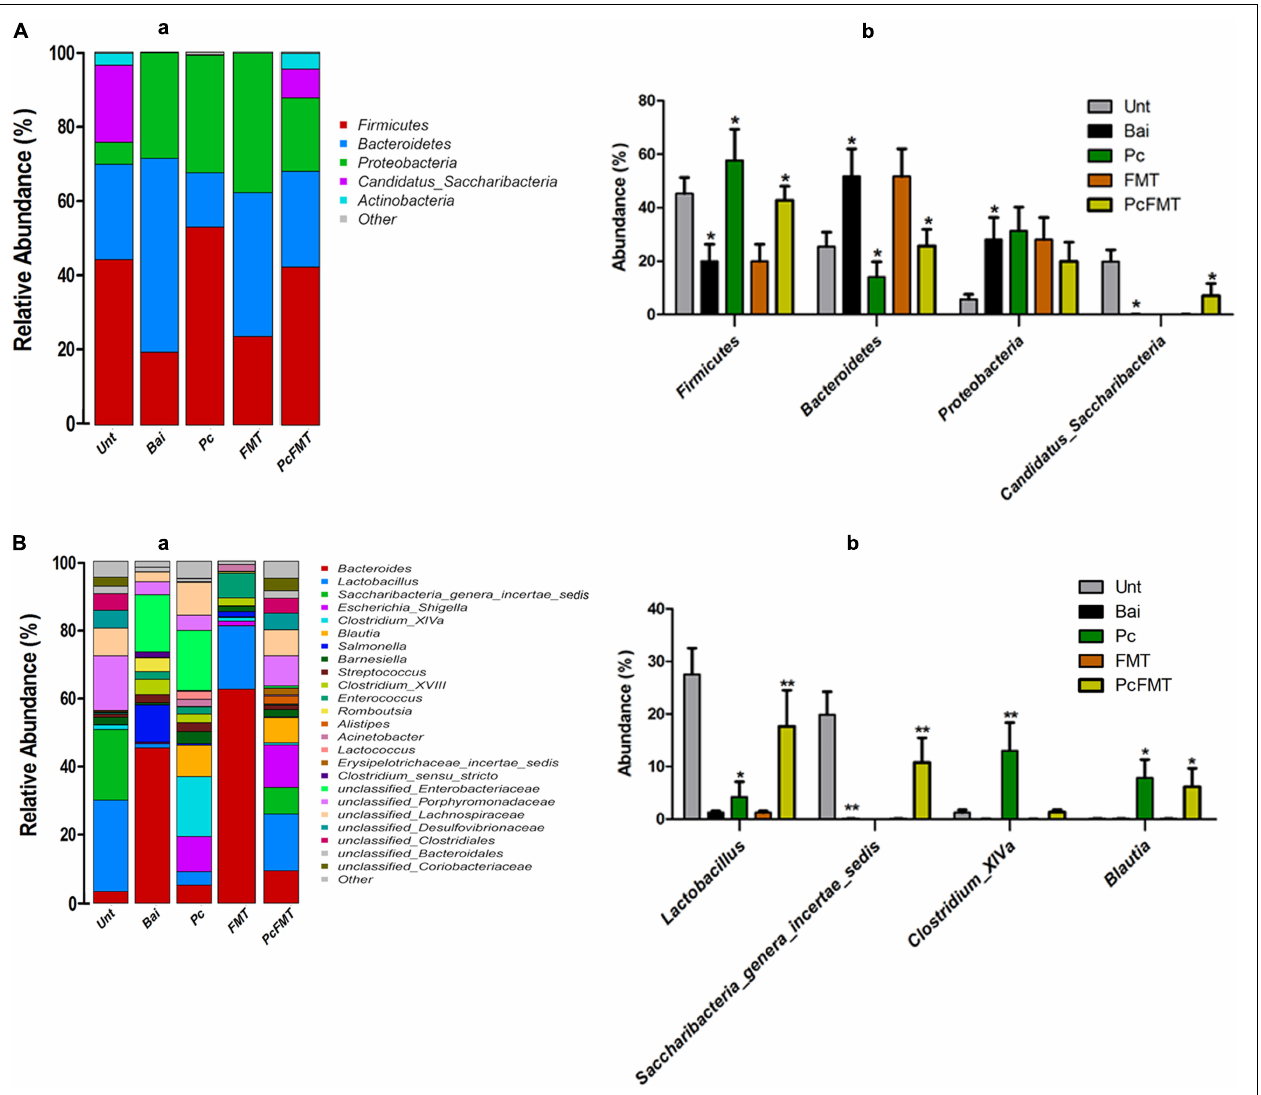
FIGURE 7 | PcFMT recovered the microbiota community structures of S. Typhimurium-induced colitis mice. The microbiota of fresh faeces collected from healthy, bacteria-infected, single-dose Pc-treated, FMT-treated, and PcFMT-treated mice were detected by amplifying the V3–V4 region of the 16S rRNA gene using specific primers (Nobar_341F-805R). Relative abundance of predominant bacteria at the phylum (A) level and genus (B) . “Unt” represents the untreated healthy mice group; “Bai” represents the bacterial-infected mice group; “Pc” means the phage cocktail-treated mice group; “PcFMT” represents the combined phage cocktail and FMT mice group. Data are expressed as the means ± SEM, n = 6. * P < 0.05; ** P <